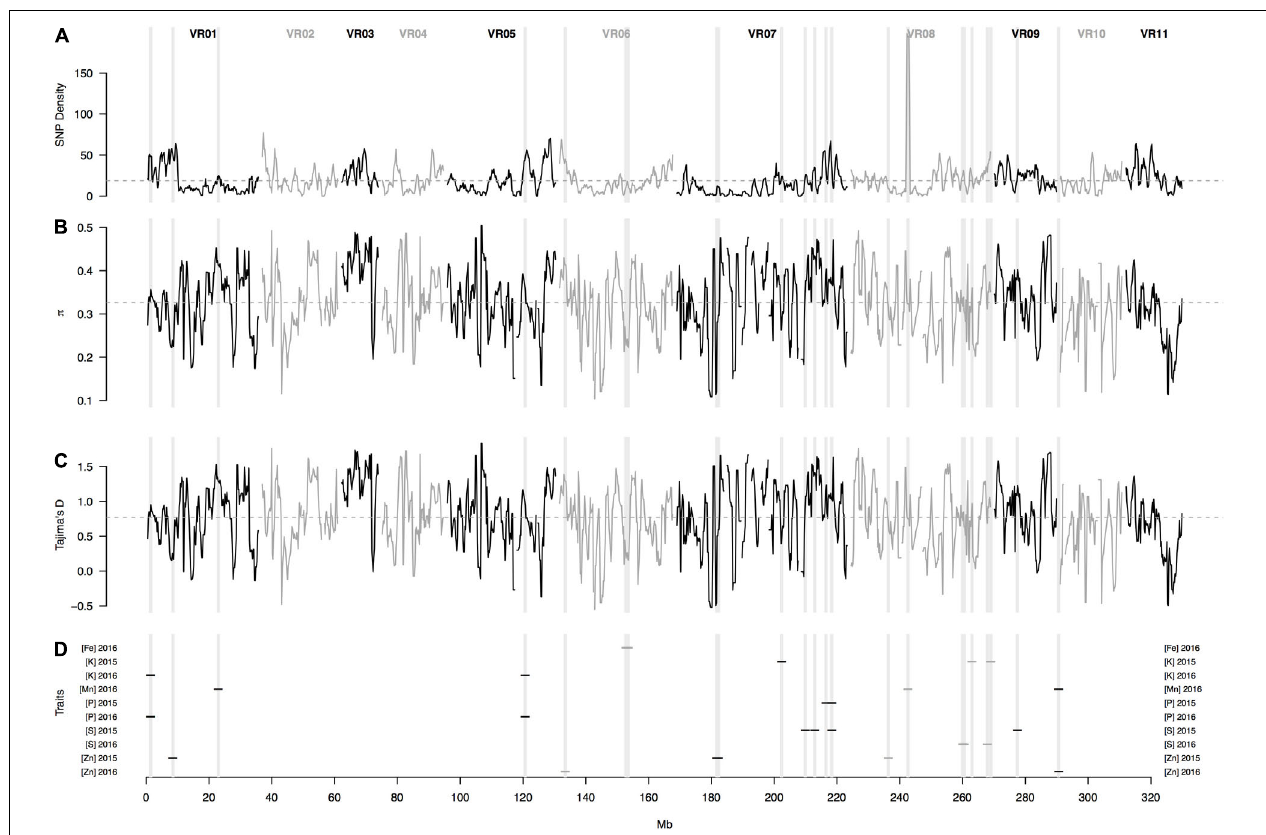
FIGURE 6 | Patterns of genome-wide diversity based on 6,486 SNP markers developed from Genotyping by Sequencing (GBS) of 95 mung bean ( Vigna radiata ) accessions. A sliding window analysis (window size = 1 Mb, step size = 200 Kb) was used to compute (A) SNP density, (B) nucleotide diversity as measured by π , and (C) Tajima’s D. (D) shows the SNP loci significantly associate with various seed mineral concentrations in two different years. Results of all windowed analyses were plotted against window midpoints in millions of base pairs (Mb). Black and gray colors highlight different mung bean (VR) chromosomes. Gray dashed horizontal lines indicate genome-wide averages. Gray vertical boxes indicate the 1 Mb flanking region of each marker that was associated with a seed mineral locus.